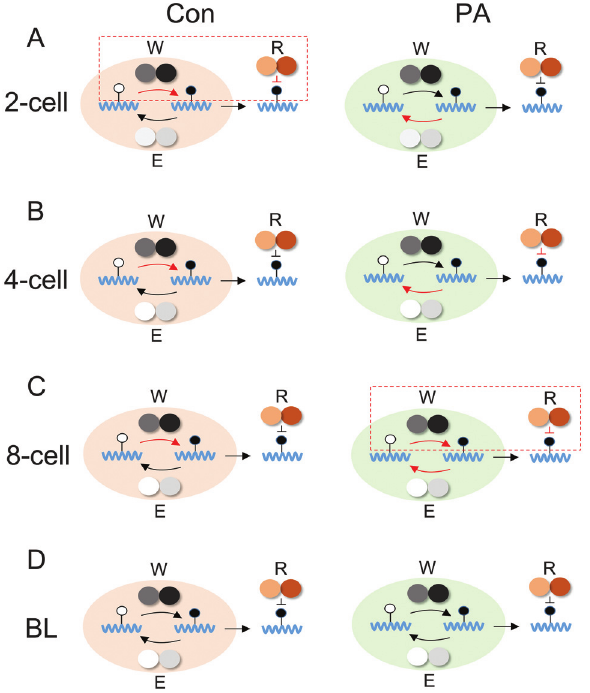
Figure 4 - Schematic representations of m6A expression patterns in 2-cell (A), 4-cell (B), 8-cell (C), and blastocyst stage (D) of normal and PA em- bryos. BL indicates the blastocyst stage of the embryo. W indicates writer ( METTL3 and METTL14 ). E indicates eraser ( FTO and ALKBH5 ). R indi- cates reader ( YTHDF2 , IGF2BP1 , and IGF2BP2 ). Red arrow and inverted T indicate the over expression of genes. The red dotted line indicates en- hance m6A